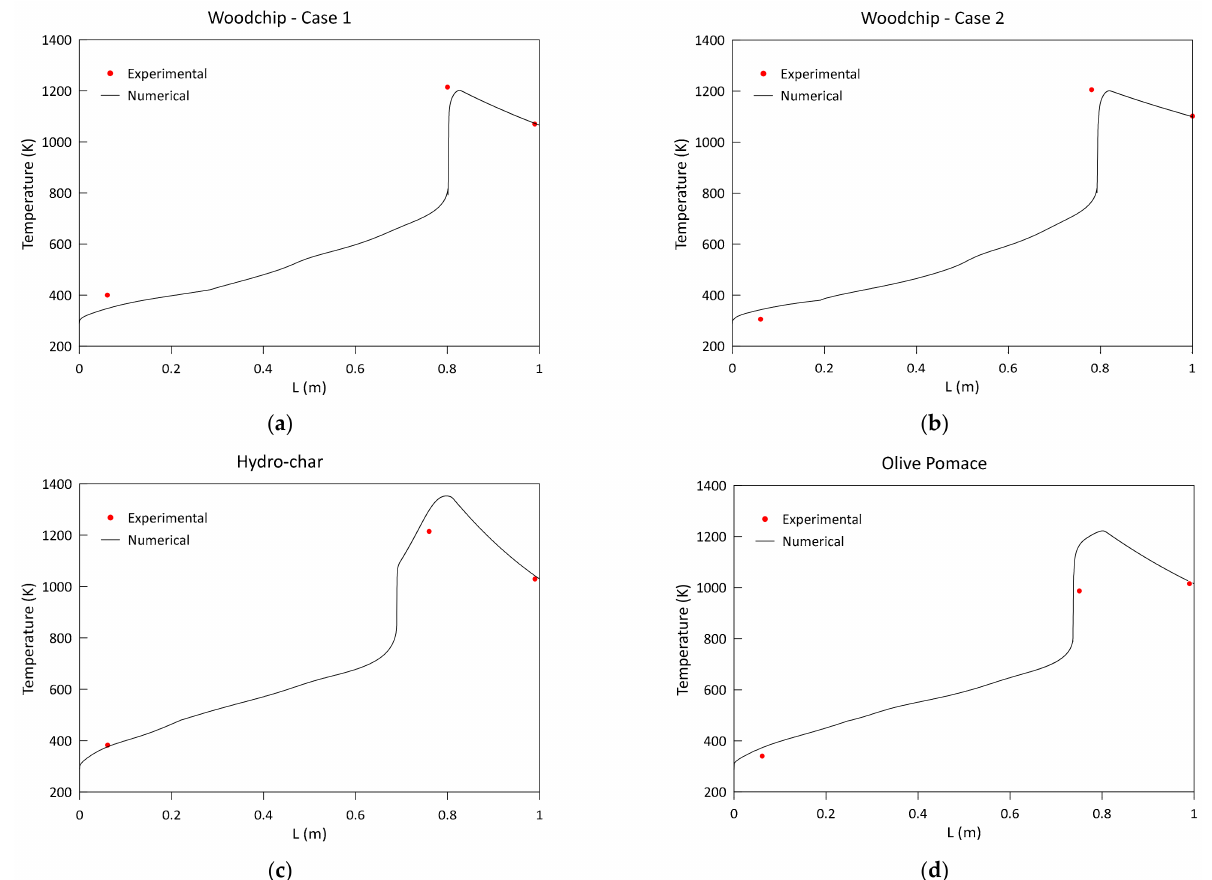
Figure 3. Comparison between the experimental measurements and the numerical temperature profile for the four biomasses/residual materials tested: ( a ) woodchip case 1, ( b ) woodchip case 2, ( c ) hydro-char from green waste, ( d ) olive pomace.